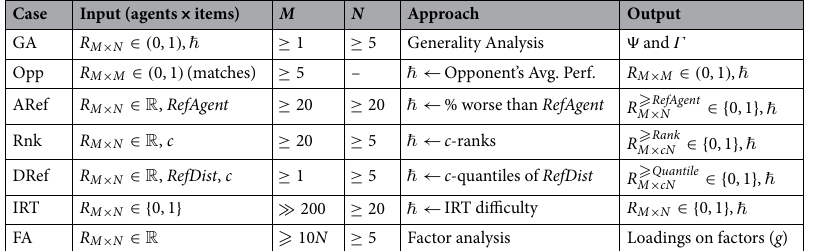
Table 1. Several modalities for applying generality analysis depending on various situations and transformations. We show the input (size and types of the response matrix R and some other information), the minimum sizes (approximate rules of thumb in some cases or statistical analysis in others 43 ), a short description of the approach and the output. The top row (case GA) is the canonical case, as it starts with a difficulty function (cid:31) . All the others (except the last one, included for completeness, and similar for PCA) derive the difficulty function (which jointly with the response matrix can be used as input for the first case, the